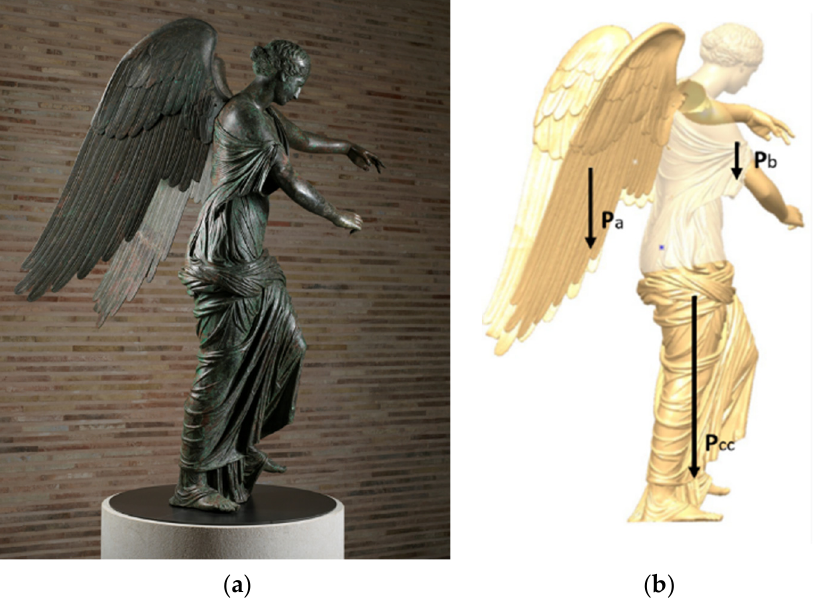
Figure 3. Case study—ancient bronze statue (Vittoria Alata): ( a ) The Vittoria Alata di Brescia (© Foto StudioRapuzzi Brescia); ( b ) Application of loads in their respective COGs.